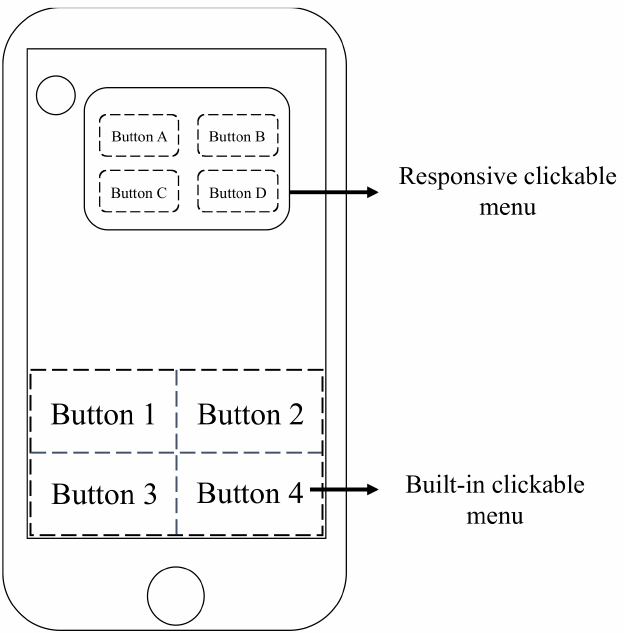
Figure 6. The developed method uses a clickable menu as the interface of the rule-based querying